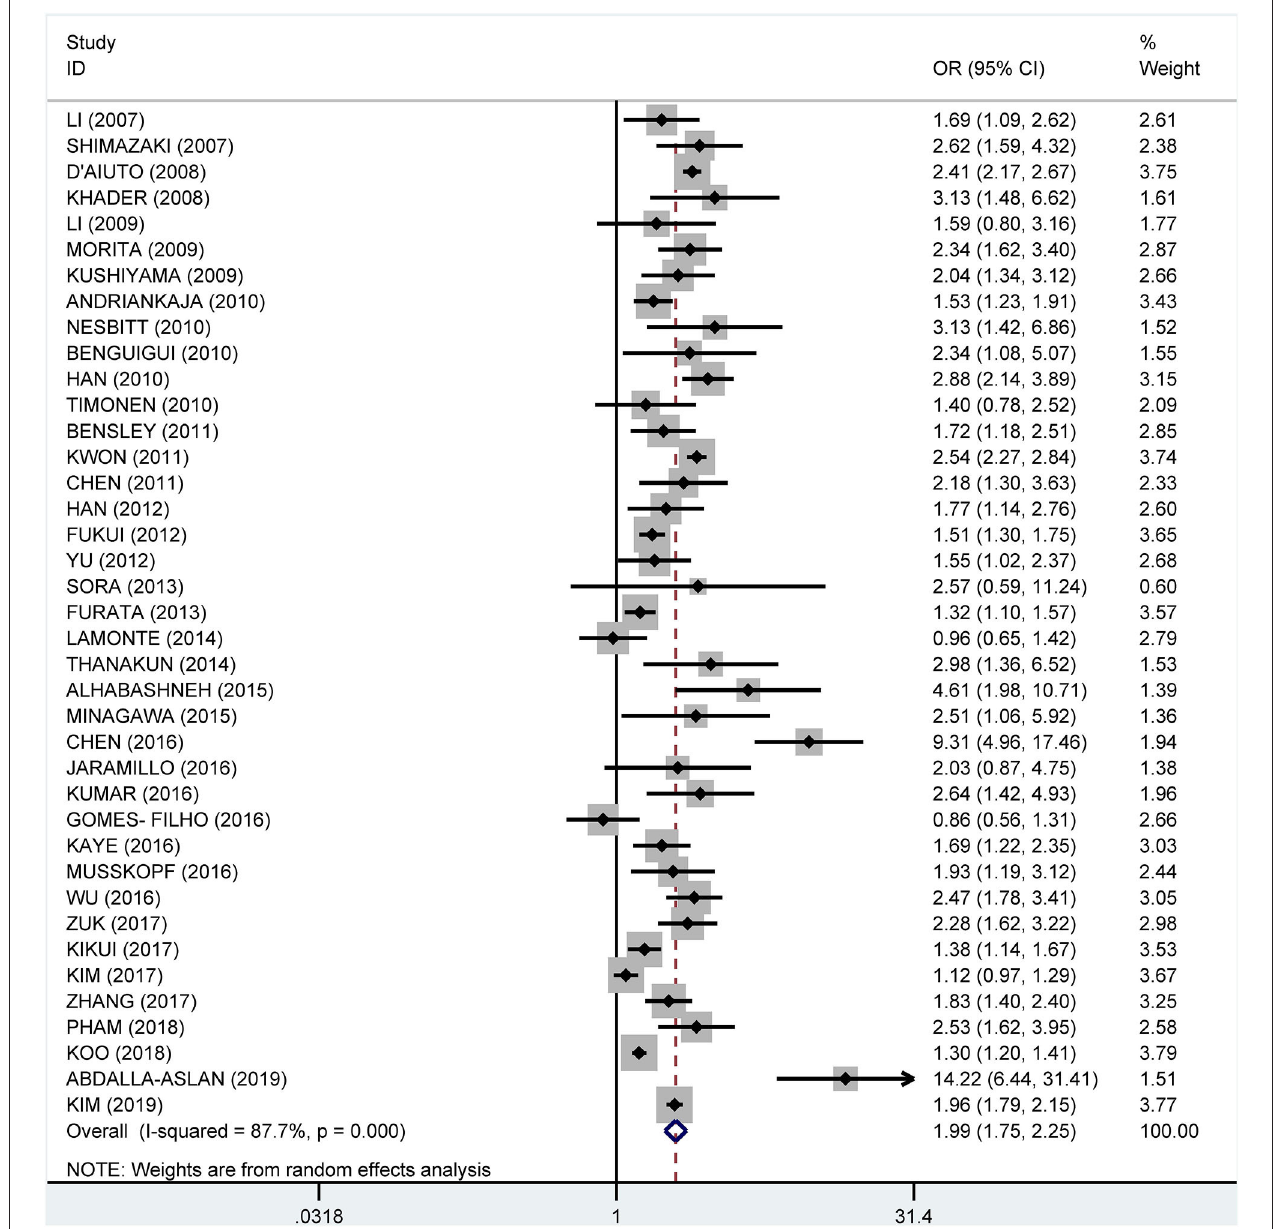
FIGURE 3 | Pooled crude odds ratios of the association between periodontitis and metabolic syndrome.